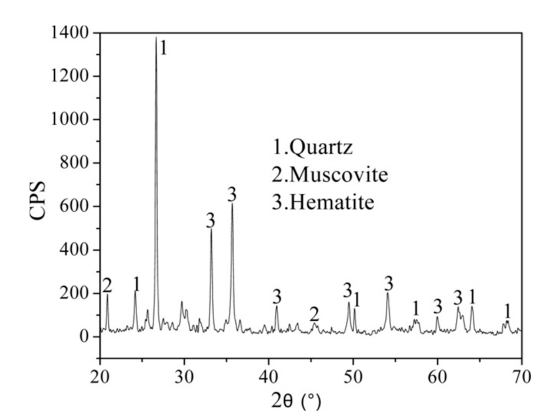
Figure 2. XRD pattern for the ore sample from the near ‐ surface oxide zone.